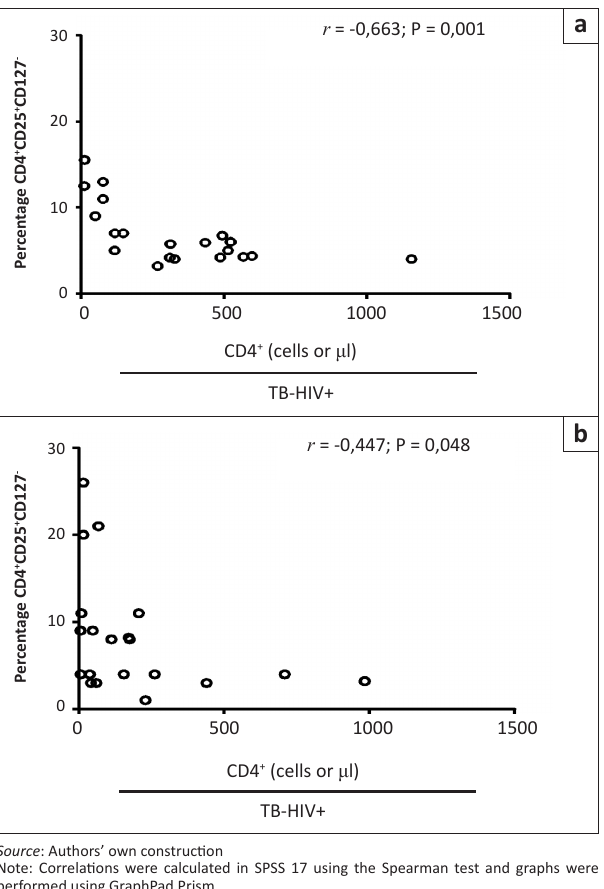
FIGURE 6: Correlation between CD4+ T-cell counts and frequencies of Treg cells. Negative correlation between CD4 + CD25 + CD127 – T-cells and CD4+ T-cell count (A) in TB–HIV+ group ( r = –0.663, p = 0.001) and (B) in TB+HIV+ group ( r = –0.447, p =